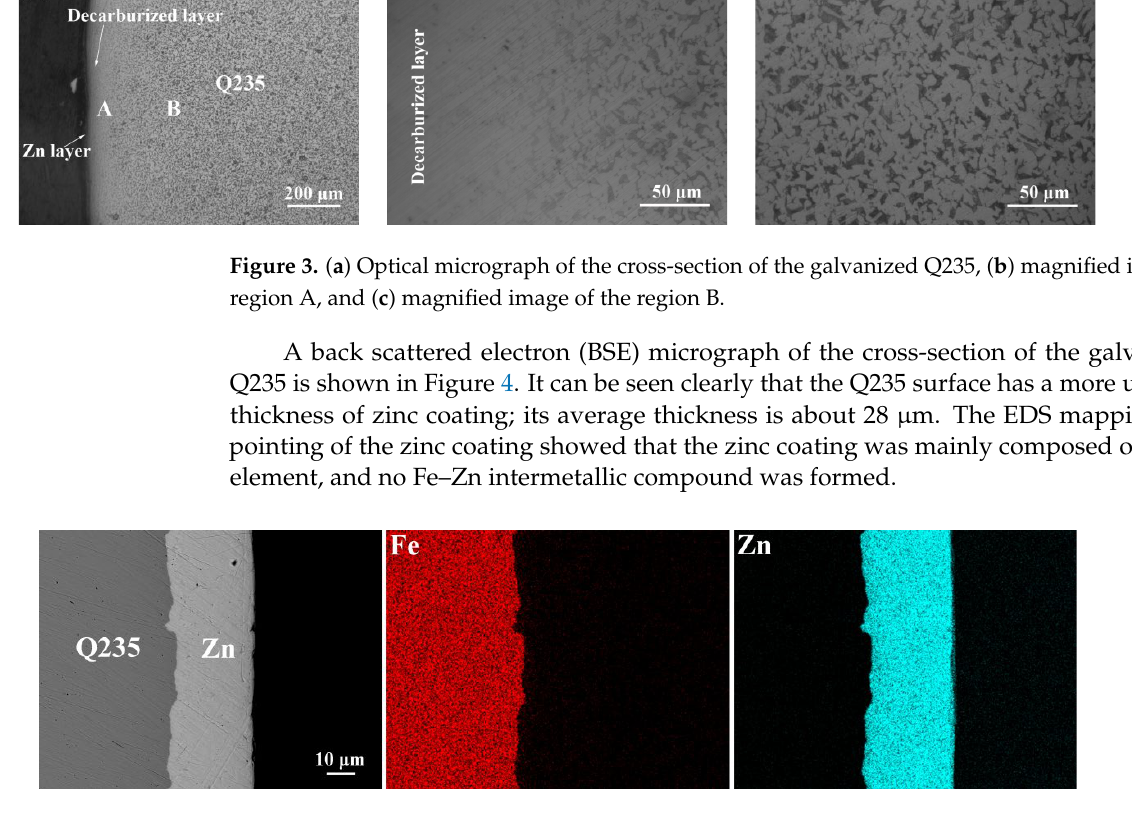
Figure 4. Mapping of the galvanized Q235.